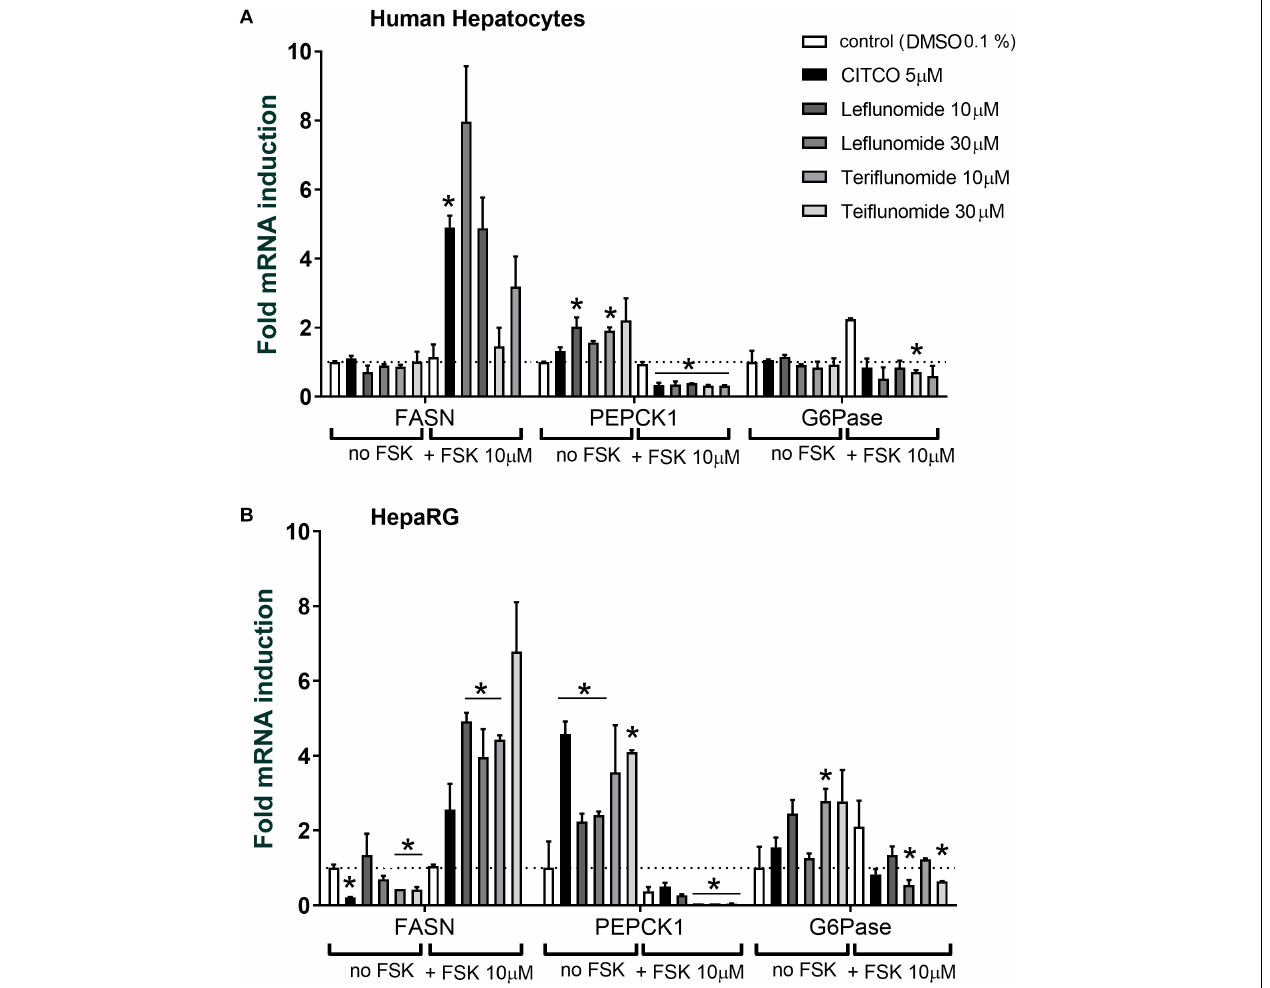
FIGURE 7 | Expression of FASN, PEPCK1, and G6Pase genes mRNAs after treatment with leflunomide and teriflunomide in human hepatocytes (A) and HepaRG cells (B) . Cells were either pre-treated or not with forskolin (FSK, 10 µ M) for 1 h and then treated with CITCO, leflunomide or teriflunomide at concentrations 10 and 30 µ M, and vehicle, for 48 h before the isolation of mRNA and qRT-PCR analyses. Data are presented as the mean ± SD of fold mRNA induction from three independent cell cultures ( n = 3) and compared to the vehicle(DMSO)-treated samples with or without FSK treatment (set to 1). ∗ P < 0.05 – statistically significant difference compared to the control (DMSO-treated) cells with or without FSK pre-treatment (ANOVA with a Dunnett’s post hoc